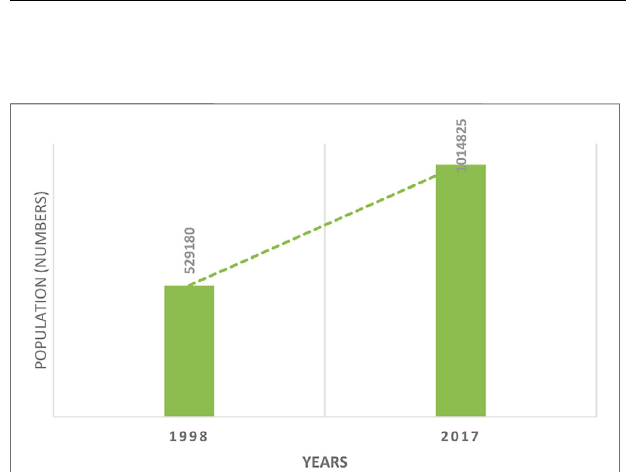
FIGURE4| RelationshipofTDSwith (A) cations, (B) anions, (C) relationshipofAsandFe,and (D) principalcomponentanalysis(PCA)inIslamabadwatersamples (Sohail et al., 2020).